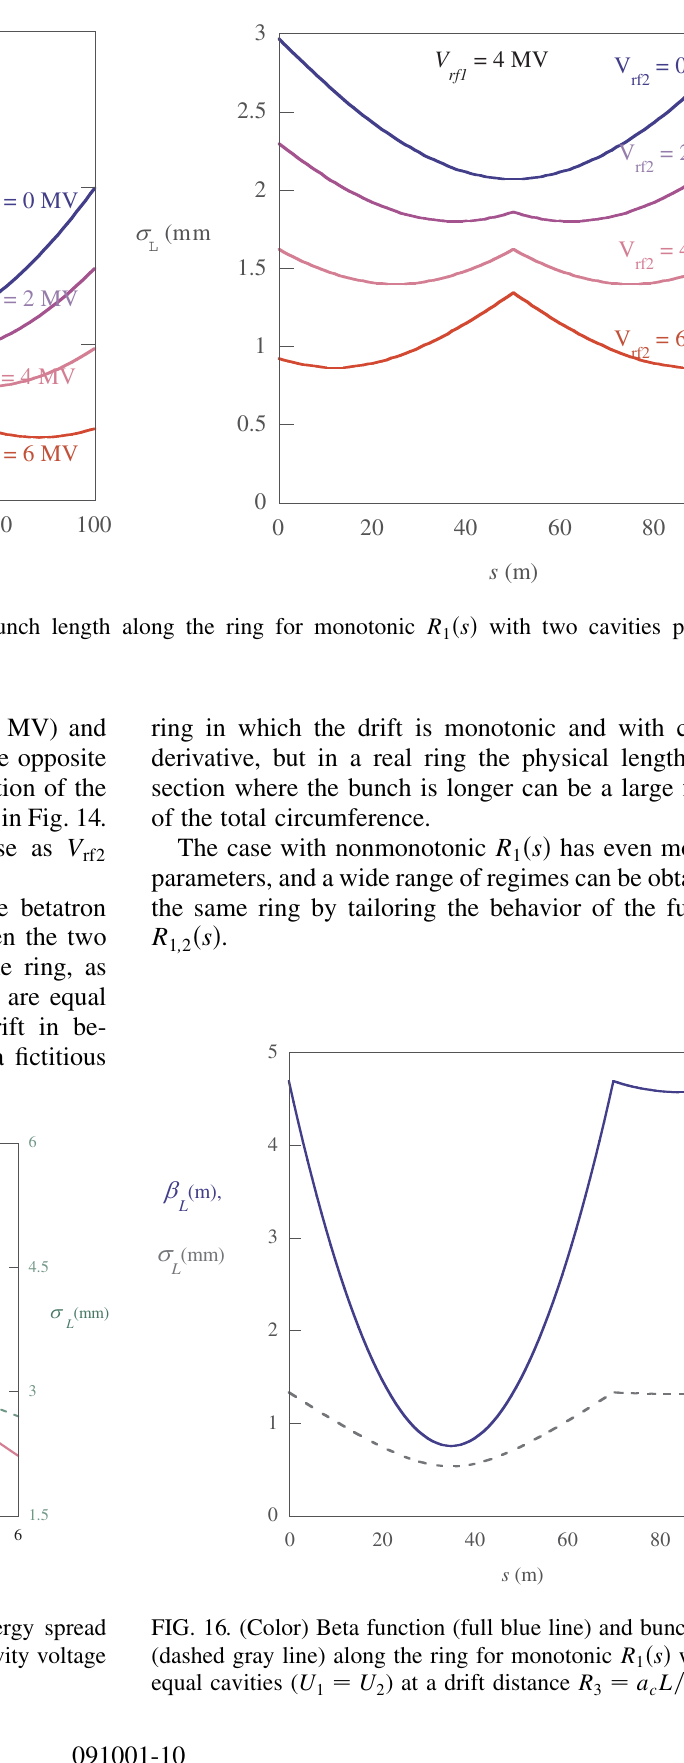
(cid:3) s (cid:4) with two 1 (cid:6) a L= 3 c 3